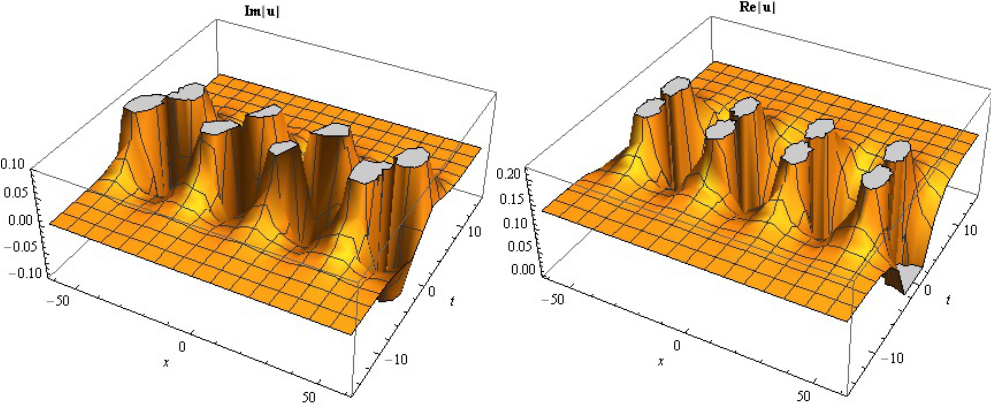
Figure 3. The 3D figures of u 5 for α 2 = 0.1, α 3 = 0.32, ε = 1, w = 0.012, A 2 = 0.2, c = 0.3, y =